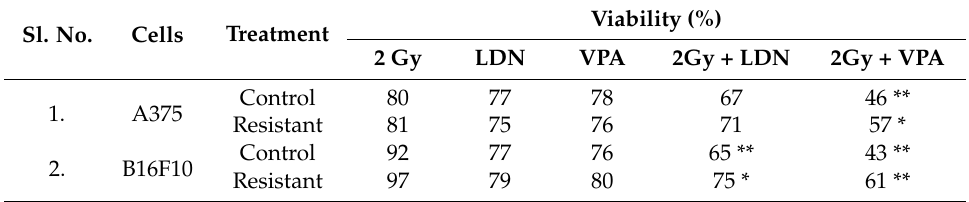
Table 2. Effect of drug, radiation, and combination treatment on the B16F10 and A375 cells. Sl. No.